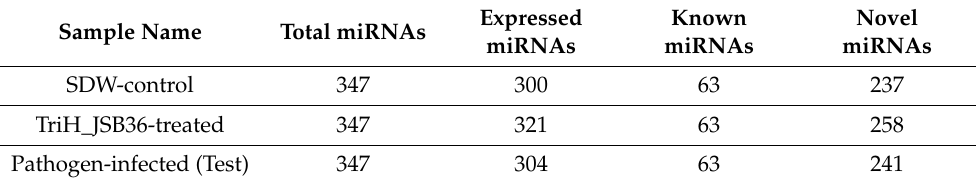
Table 2. Identification of total novel and known miRNAs obtained from SDW-control, TriH_JSB36- treated, and pathogen-infected (Test) samples with miRDeep score.